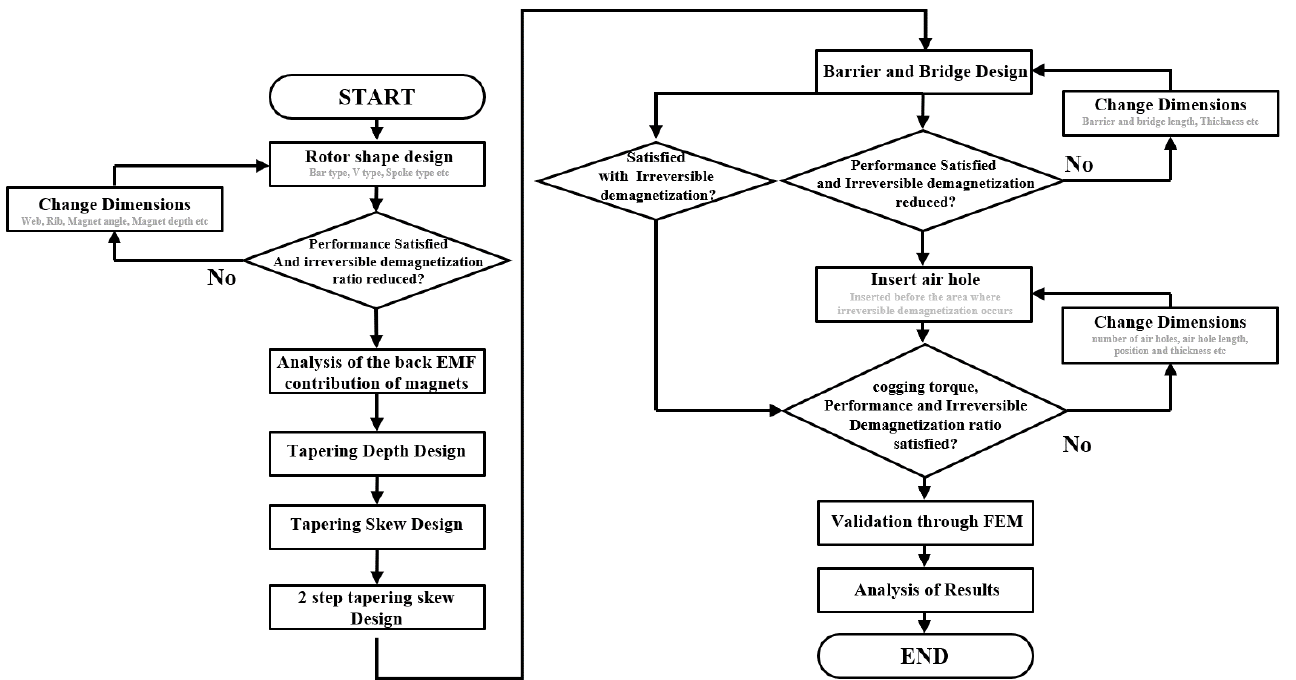
Figure 1. A rotor design process to reduce irreversible demagnetization and cogging torque.